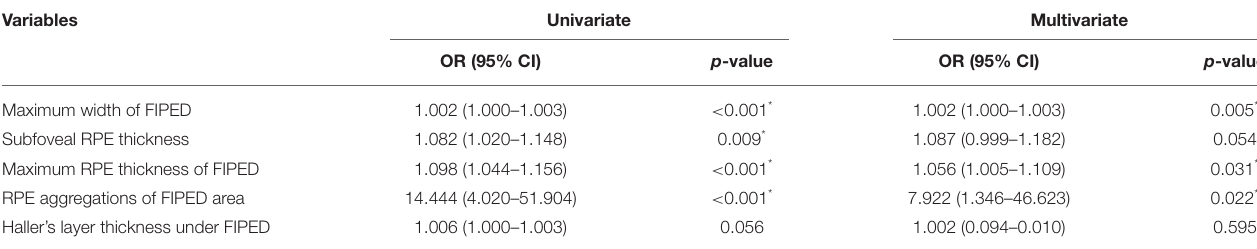
TABLE 4 | Multivariate analysis of factors associated with vascularized FIPED in chronic CSC.